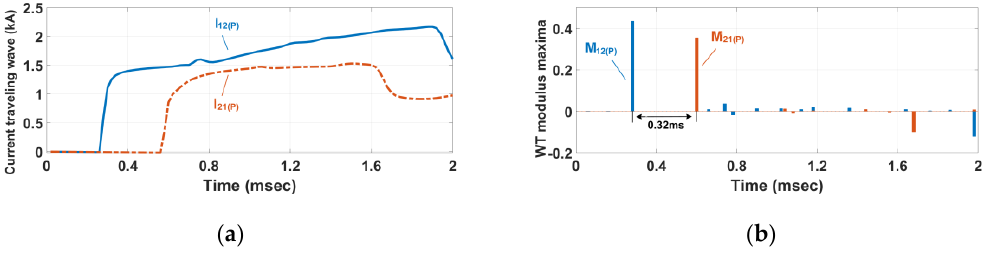
Figure 10. ( a ) Waveforms of current traveling waves at both ends of the positive line in the segment L 12 ; ( b ) Waveforms of their corresponding wavelet transform (WT) modulus maxima.